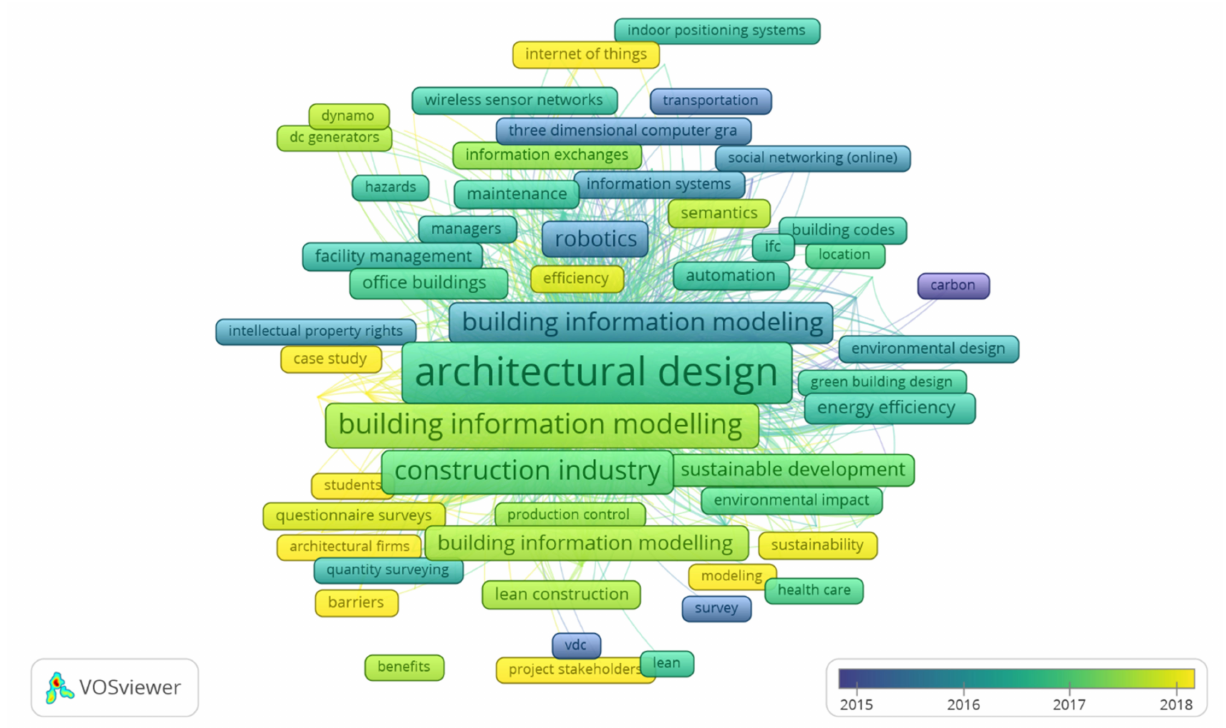
Figure 11. Current research